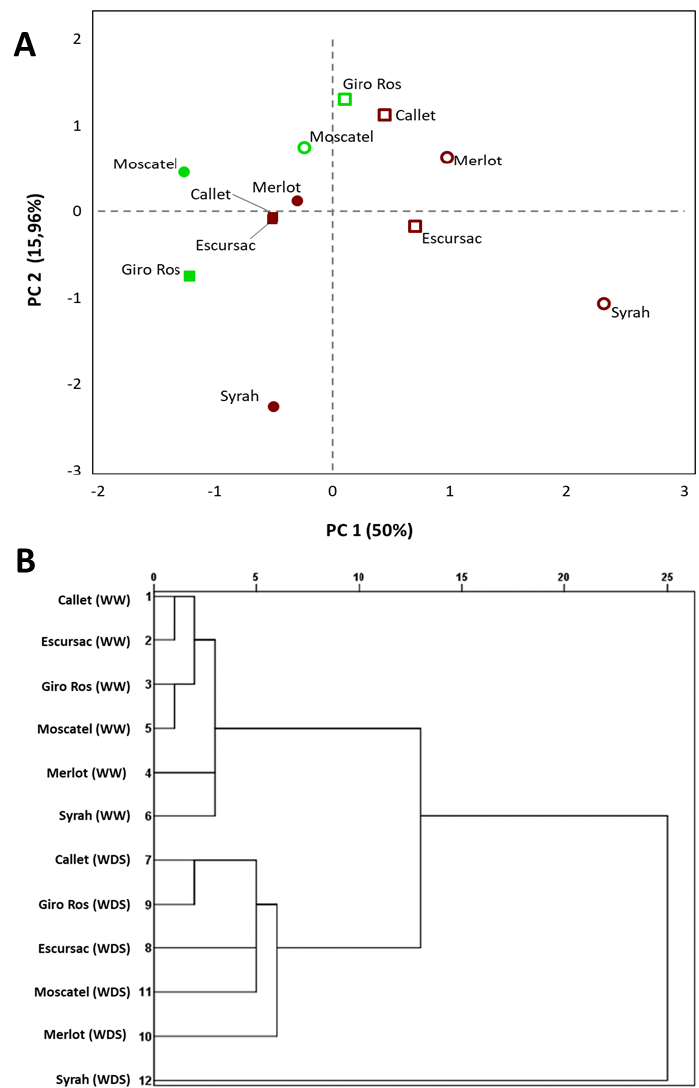
Figure 2. Multivariate analysis of metabolic changes associated with cultivar and water deficit stress. ( A ) Principal component analysis (PCA) of grapevine varieties under well-watered (WW) and water deficit stress (WDS) treatments. Filled/empty symbols means WW/WDS conditions respectively. Circles/squares means widespread/local varieties respectively and maroon/green colors means red/white varieties. ( B ) Dendrogram showing distributions, distances and the grouping among the different cultivars and water treatments using all the metabolite data.